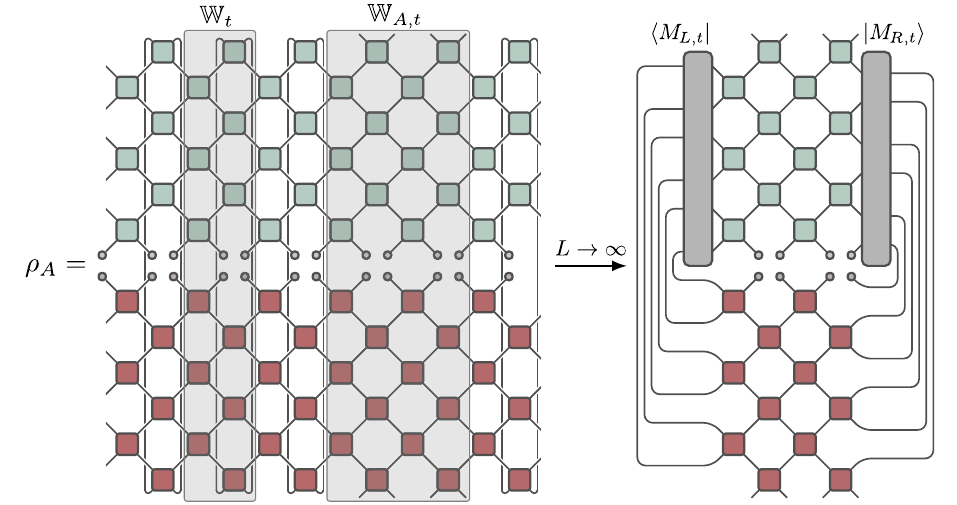
FIG. 1. Diagrammatic representation of the reduced density matrix. The reduced density matrix ρ is obtained by evolving an initial A ¯ A of the subsystem A (graphically denoted by connecting the top and bottom legs). state in time and tracing over the complement Alternatively, we can understand it as a trace of a product of powers of the space transfer matrix W and the transfer matrix W (both t A;t shaded in gray), as given by Eq. (8). In the limit L → ∞ , the section of the tensor network corresponding to the rest of the system can be replaced by fixed points h M and j M of the space transfer matrix W [cf. Eq. L;t j R;t i t